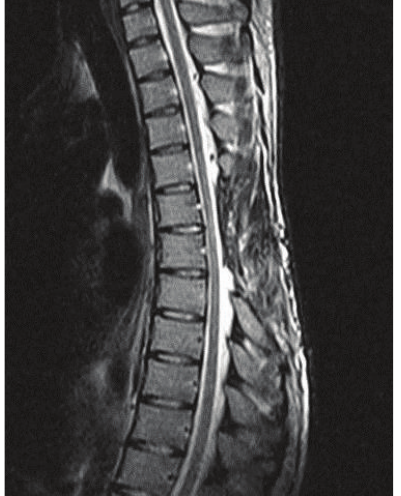
Figure 6: Postoperative 2-year follow-up sagittal MRI showed no expansive mass on the spinal cord and no recurrence.